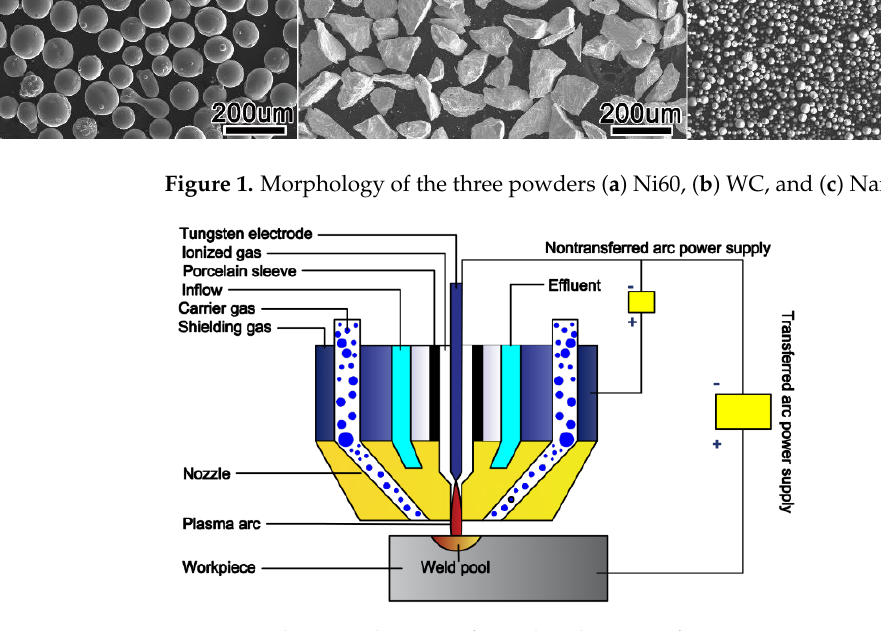
Figure 2. Schematic diagram of powder plasma surfacing equipment.